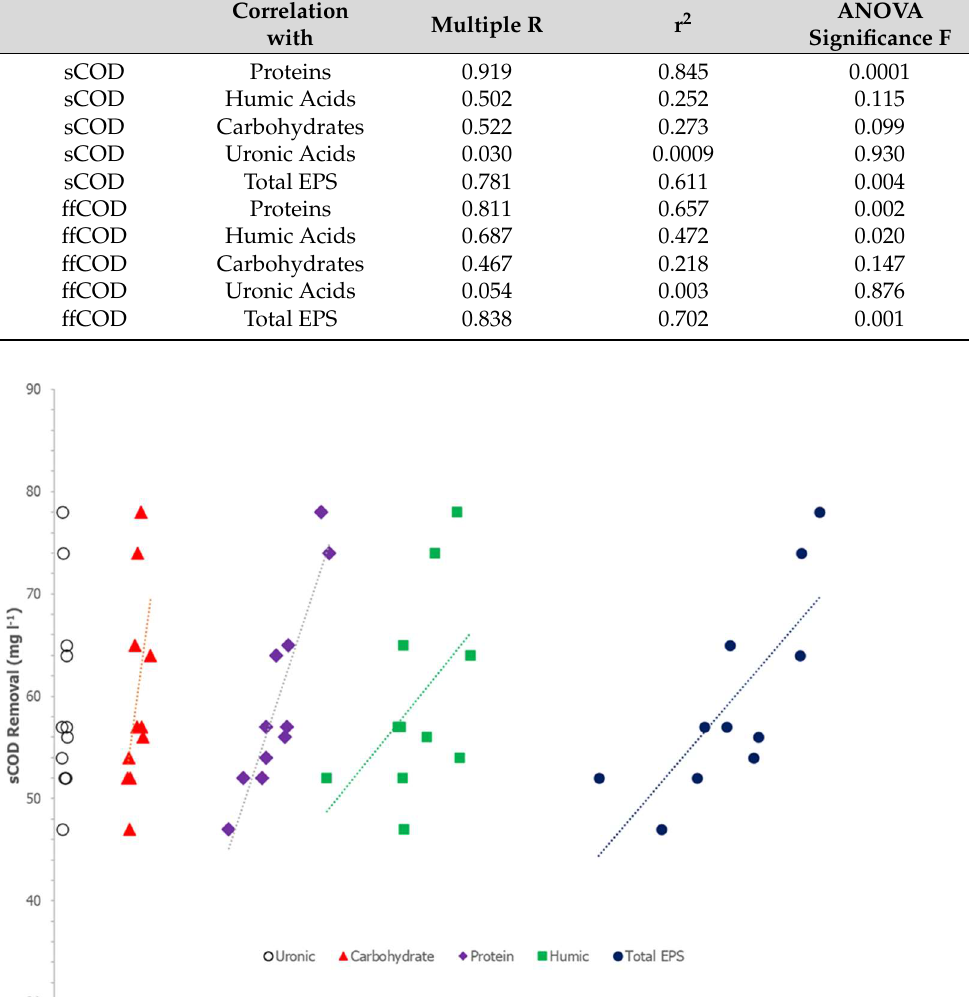
Table 3. Correlation of COD sorption with 24-h extraction time EPS Concentrations, n = 11.